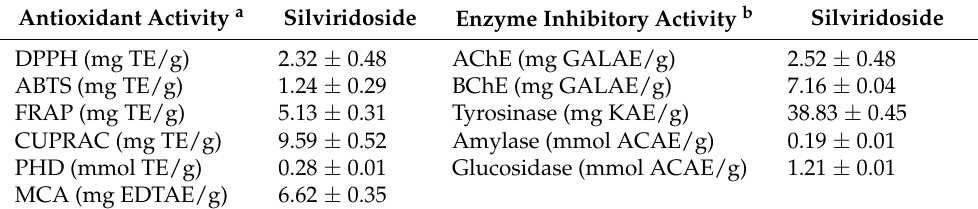
Table 3. Antioxidant and enzyme inhibitory effects of